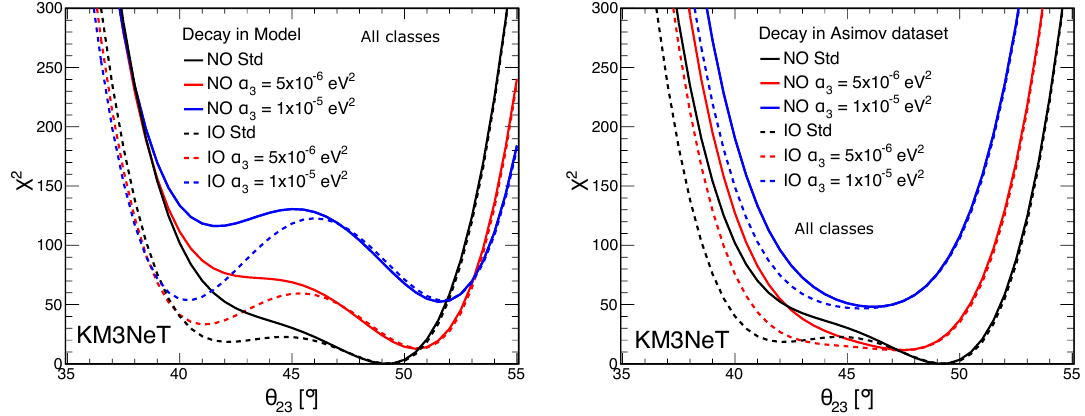
Figure 8. Statistical χ 2 as a function of the scanned value of θ 23 in the model for different values of α 3 fixed in the model (left) and in the Asimov dataset (right) for NO (solid) and IO (dashed) with all contributions summed up together. Three cases are considered, α 3 = 0 (black), α 3 = 5 × 10 − 6 eV 2 (red) and α 3 = 1 × 10 − 5 eV 2 (blue).